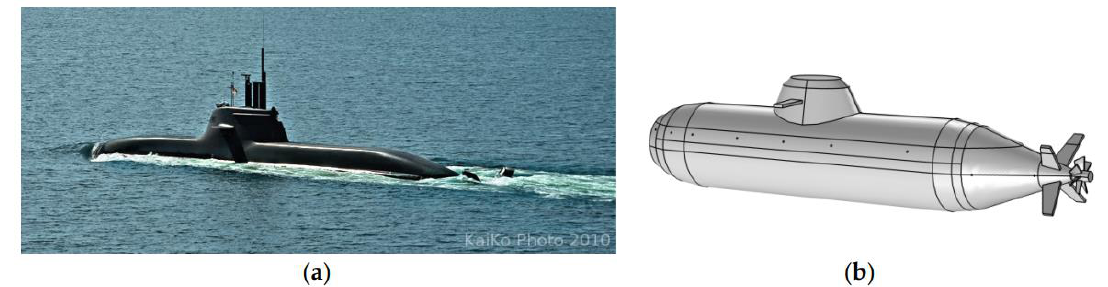
Figure 1. ( a ) Photo of a type 212A submarine and ( b ) the geometry of the numerical submarine model for simulating the AEP signature.